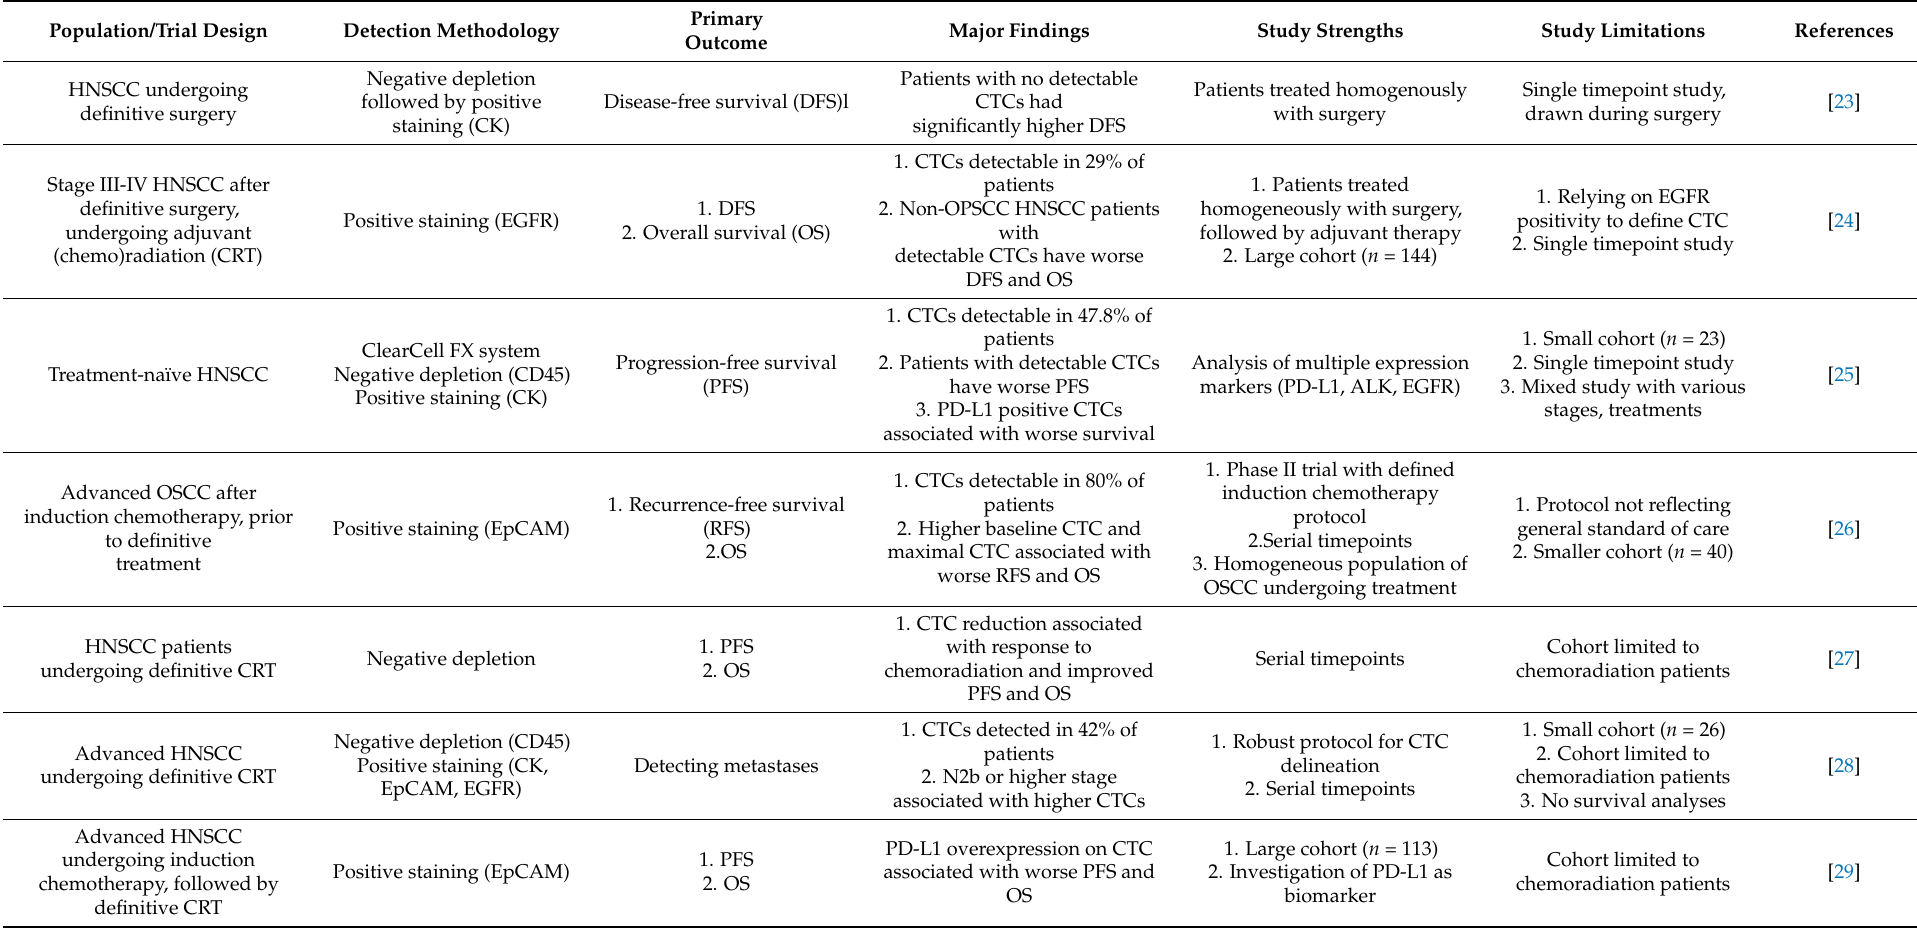
Table 1. Key studies investigating circulating tumor cells (CTCs) as biomarkers in head and neck squamous cell carcinomas